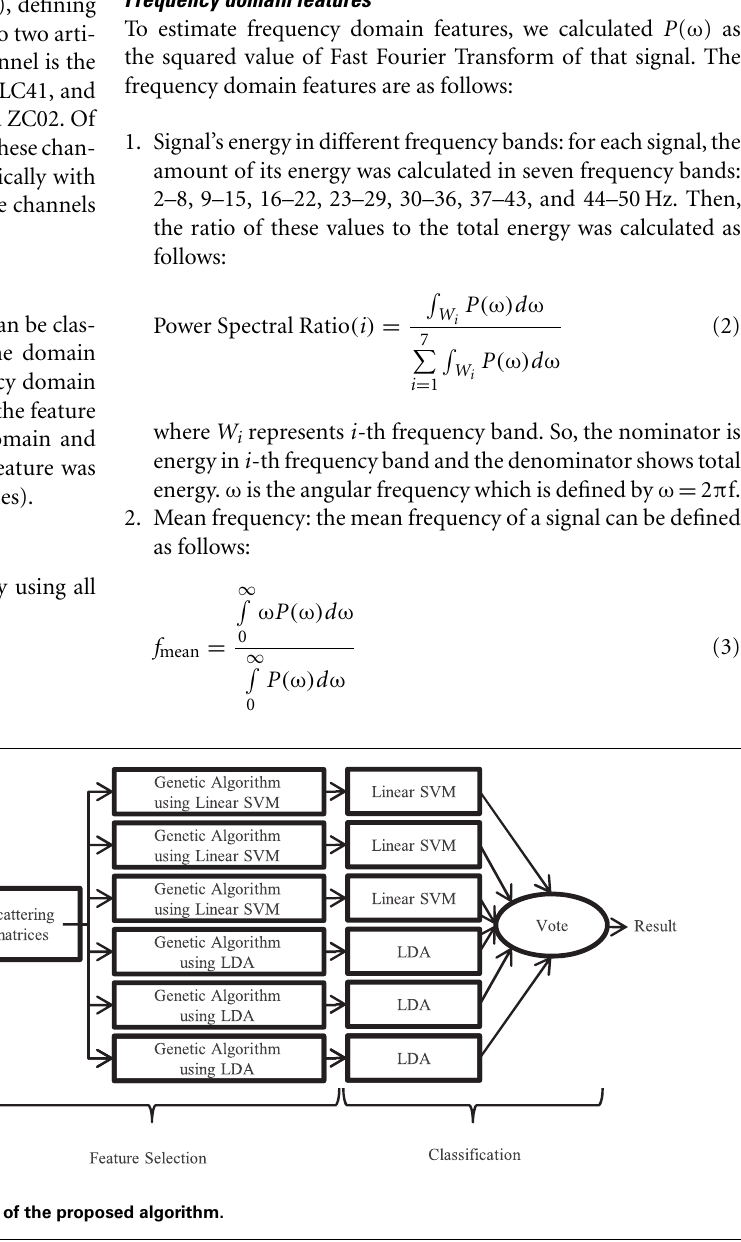
Frontiers in Neuroscience |